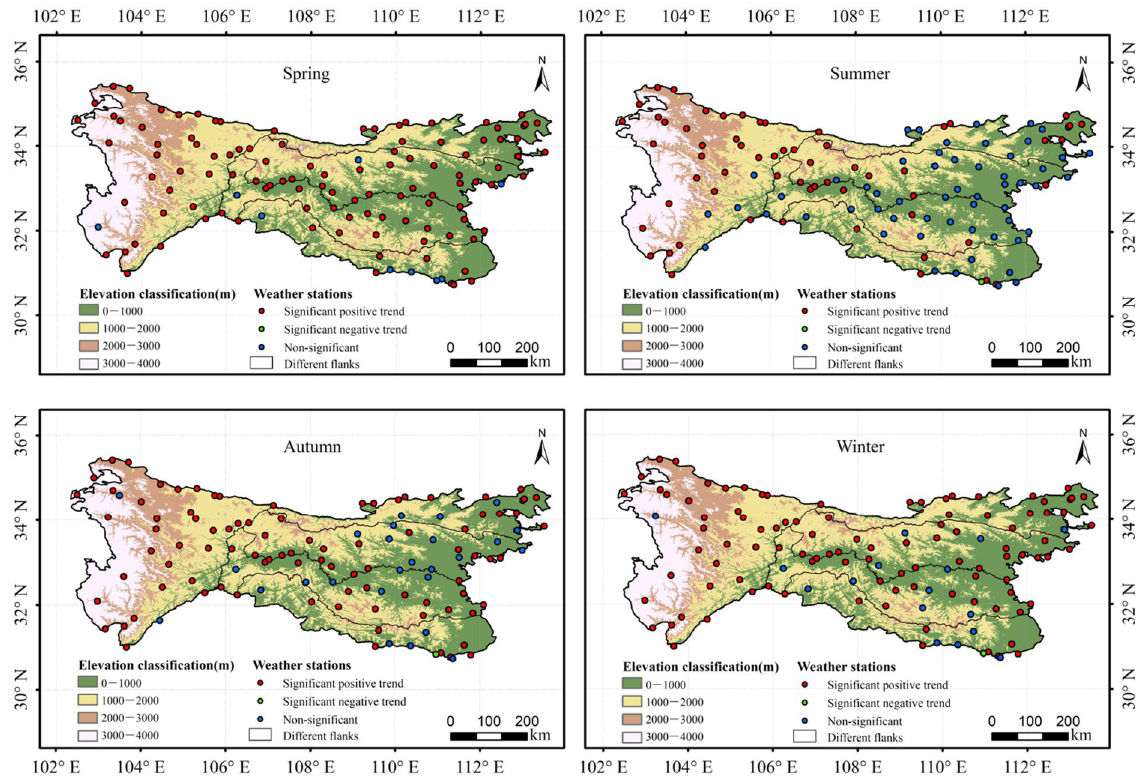
Figure 2. Significance analysis of mean air temperature based on the Mann–Kendall test at the 5% significance level at different weather stations in the QDM during 1969–2018. Notes: the map is created via the software ArcGIS 10.2 and the related research marks and words are added. The data of the map is from the site: https:// earth explo rer. usgs. gov/, https:// data. cma.